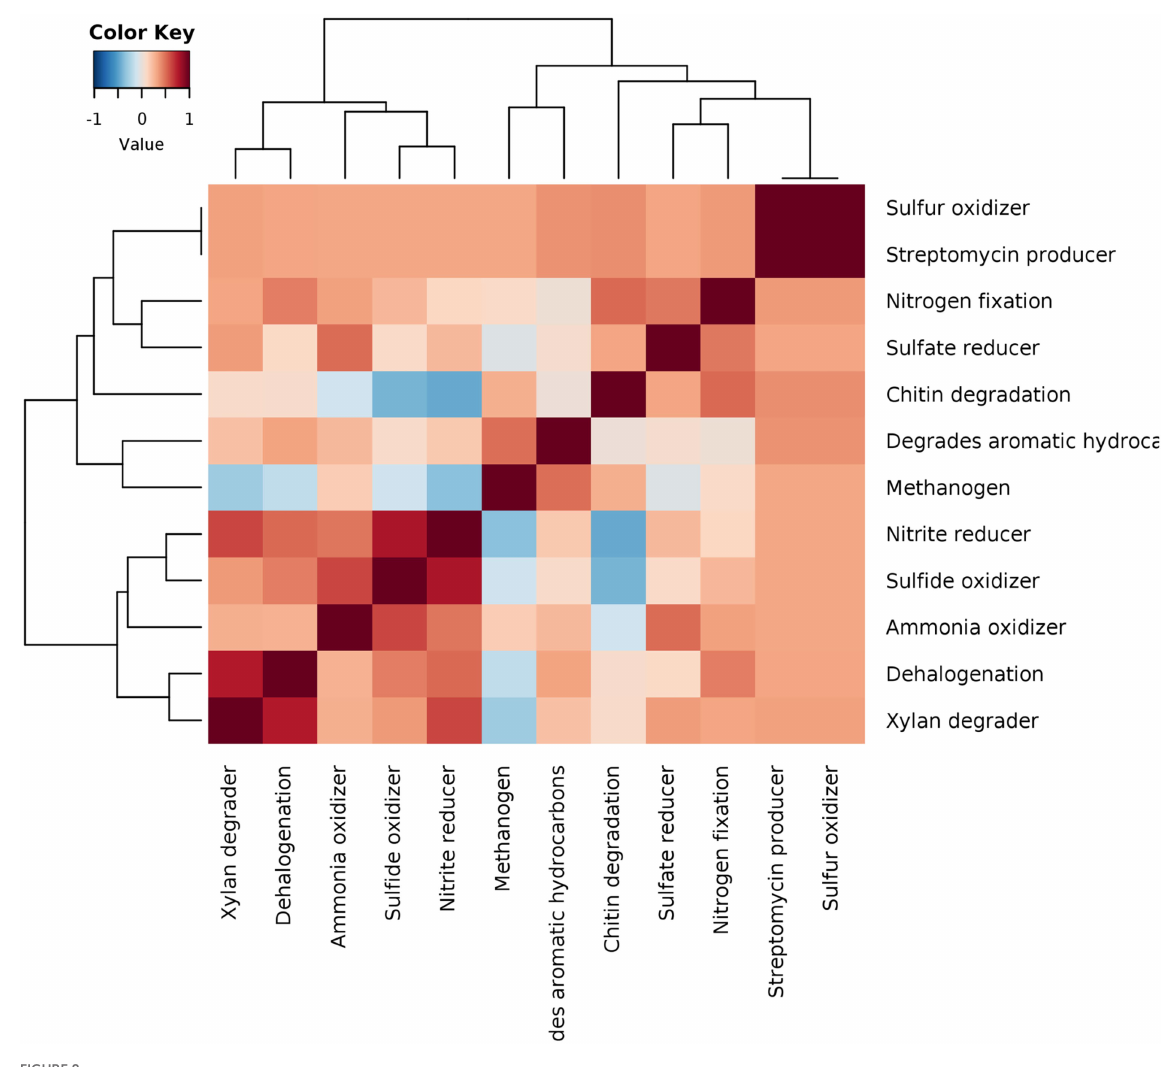
FIGURE 8 Pearson correlation based heatmap showing the distribution of important soil ecological functions associated with rhizo-microbiome of rice varieties, color gradient toward brown represents high positive correlation and toward blue represents negative